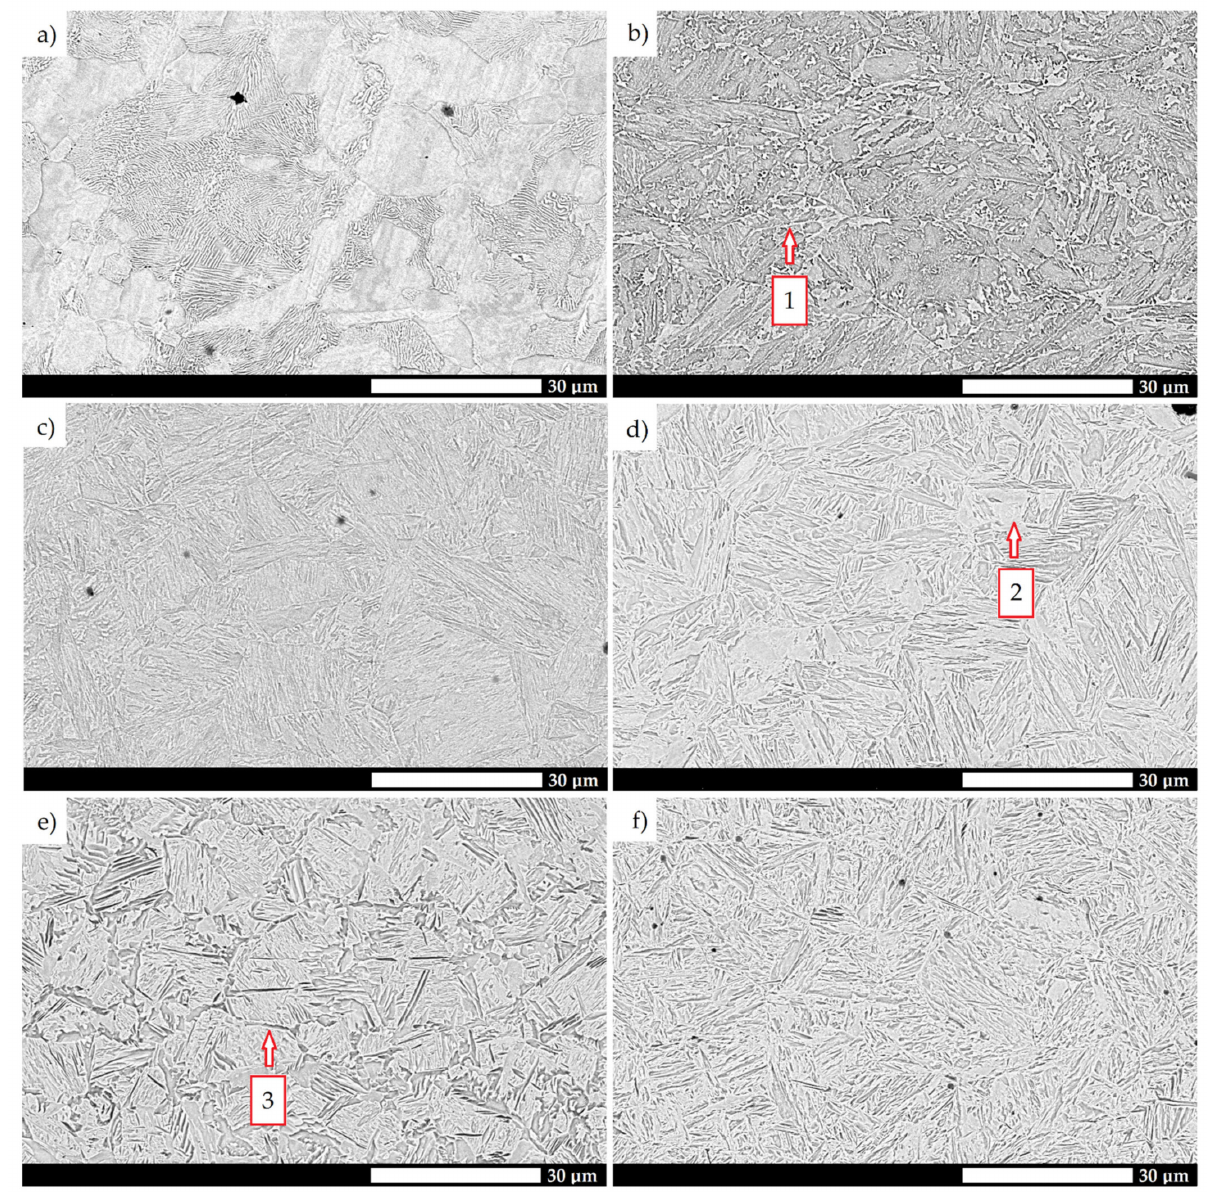
Figure 5. Microstructure of the tested types of steels: ( a ) 38GSA (N); ( b ) Creusabro 4800; ( c ) Creusabro 8000; ( d ) TBL PLUS; ( e ) XAR 600; ( f ) 38GSA (HT). 1—network of carbides distributed at the grain boundaries of the prior austenite, 2—untempered martensite, 3—non-martensitic phases at the grain boundaries of the prior austenite. SEM, etched with 5% HNO 3